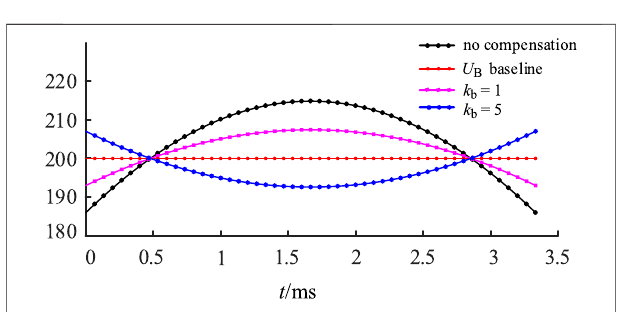
FIGURE 8 | Schematic diagram of the suppression effect of the voltage ripple.